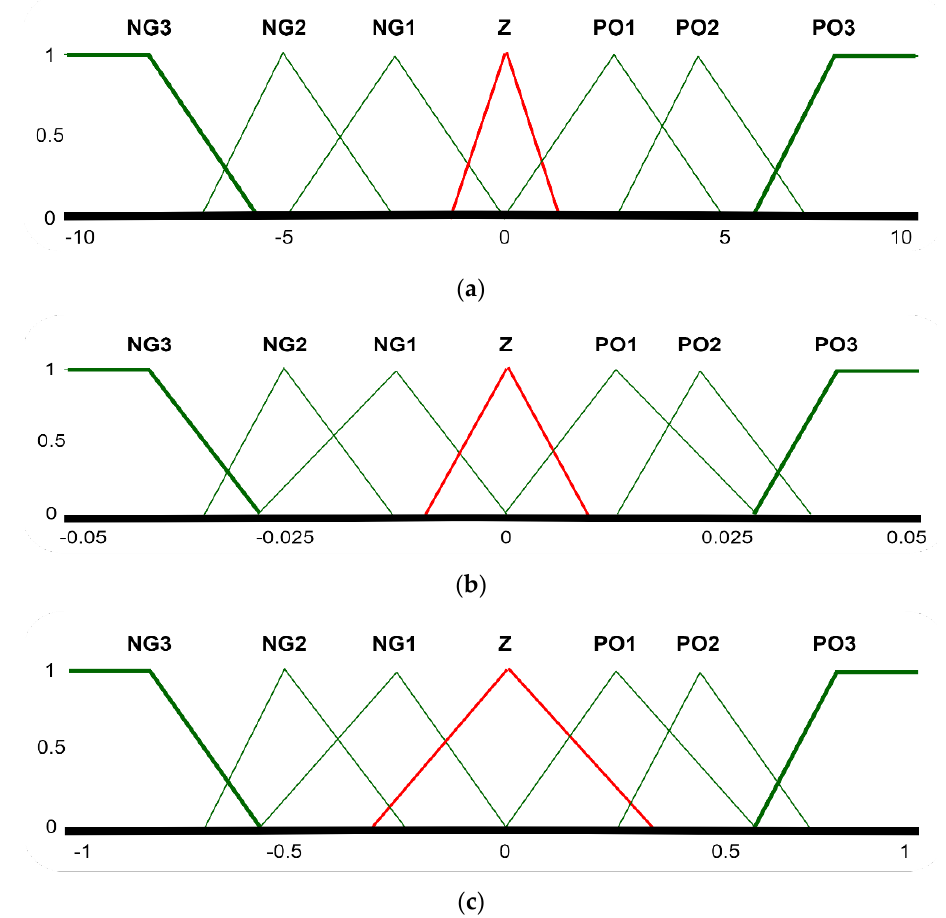
Figure 3. Variables of membership function: ( a ) first input ( e ); ( b ) second input 𝛿(𝑒) ; ( c ) output ( 𝑢 𝑃𝑊𝑀 ). Table 1. The input and output labels of FLC. Table 1. The input and output labels of FLC.